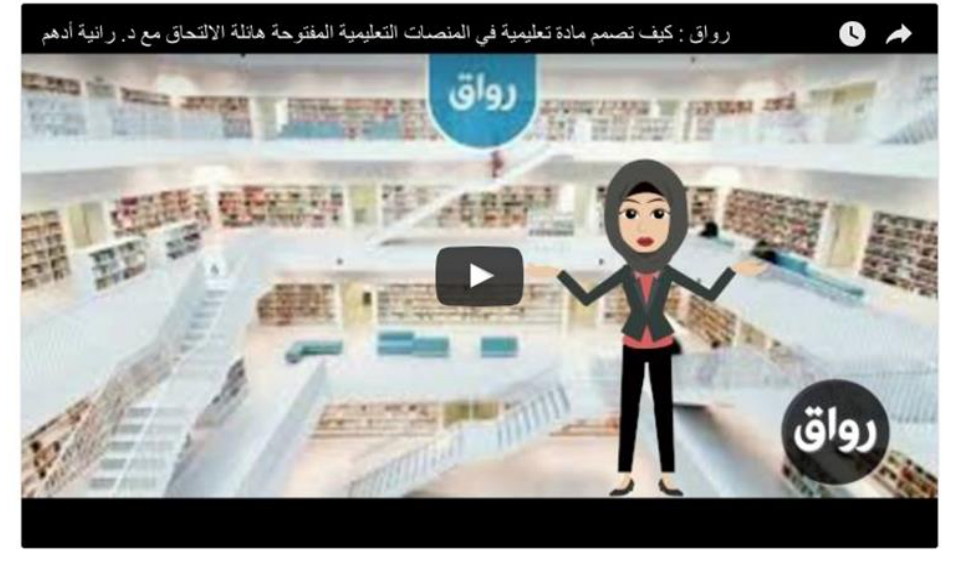
Figure 2. Screenshot of video on the Rwaq